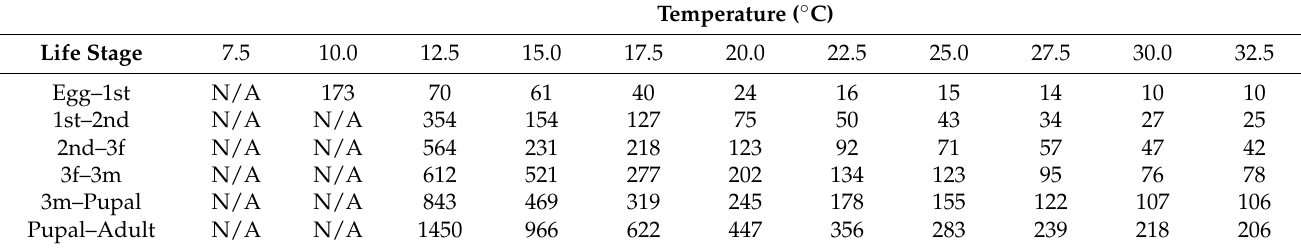
Figure 1. ( A – F ) Gaussian and modified Gaussian curves (those curves with plateau) fit to all life stages (egg to adult) of Lucilia sericata for temperatures 10.0 to 32.5 ◦ C. ( A – J ), respectively. Models were not constrained, so occasionally the best fit curve can exceed 100%. Different line colors and black dot and triangles are used to distinguish adjacent curves. Table 4. Mean time for Phormia regina to reach 50% of the population for each life stage and tempera- ture